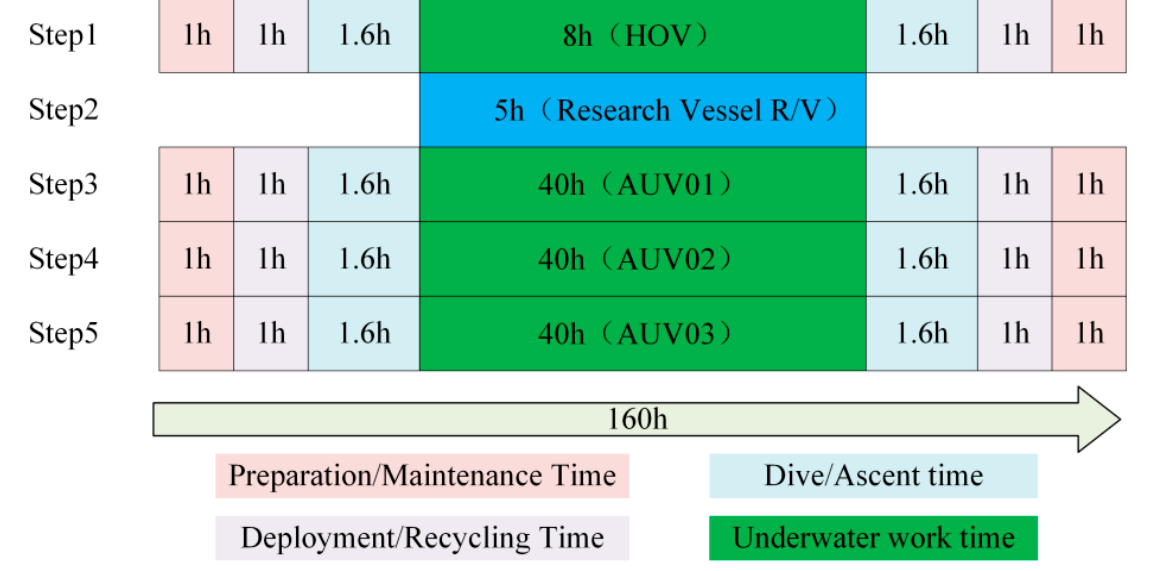
Figure 15. Elapsed time in traditional distributed operational mode (one HOV and Three AUVs)..